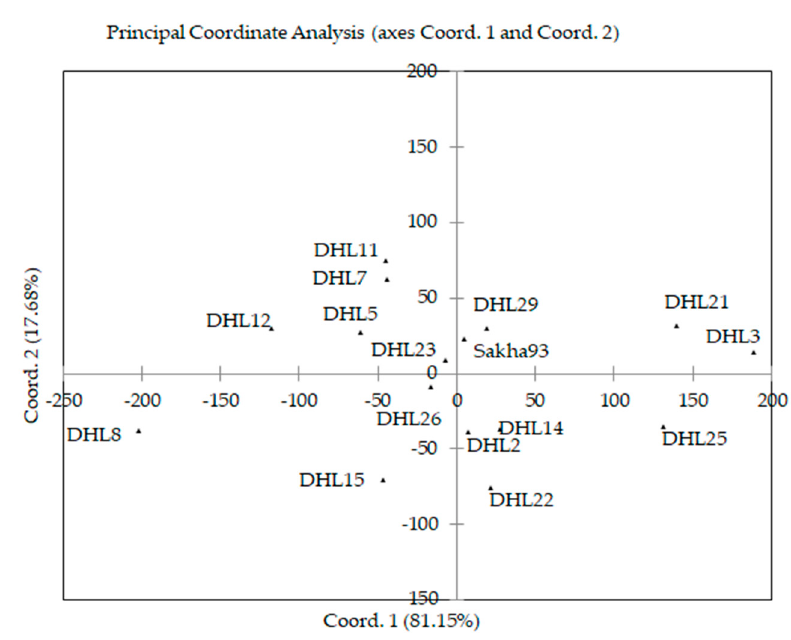
Figure 3. Principal coordinates analysis (PCoA) among the 16 wheat genotypes based on the Euclidean distance for 15 measured traits. DHL: doubled haploid line. Table 4. Principal component analysis of 16 wheat genotypes, eigenvalues, proportion, and cumulative variance for the first six components for measured traits at three salinity levels ( n = 48).